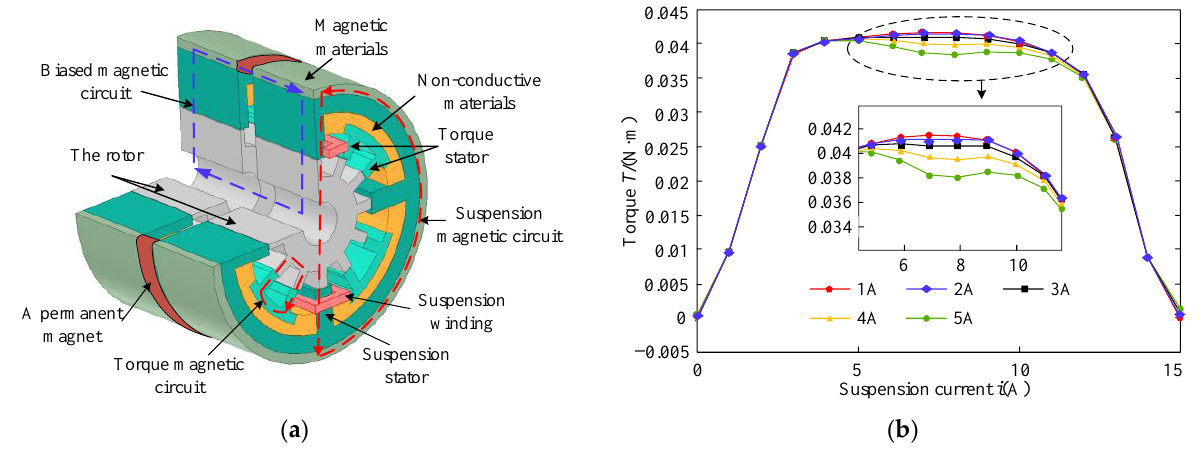
Figure 6. Axially magnetized four degrees of freedom BSRM: ( a ) Motor topology diagram; ( b ) Torque curve.